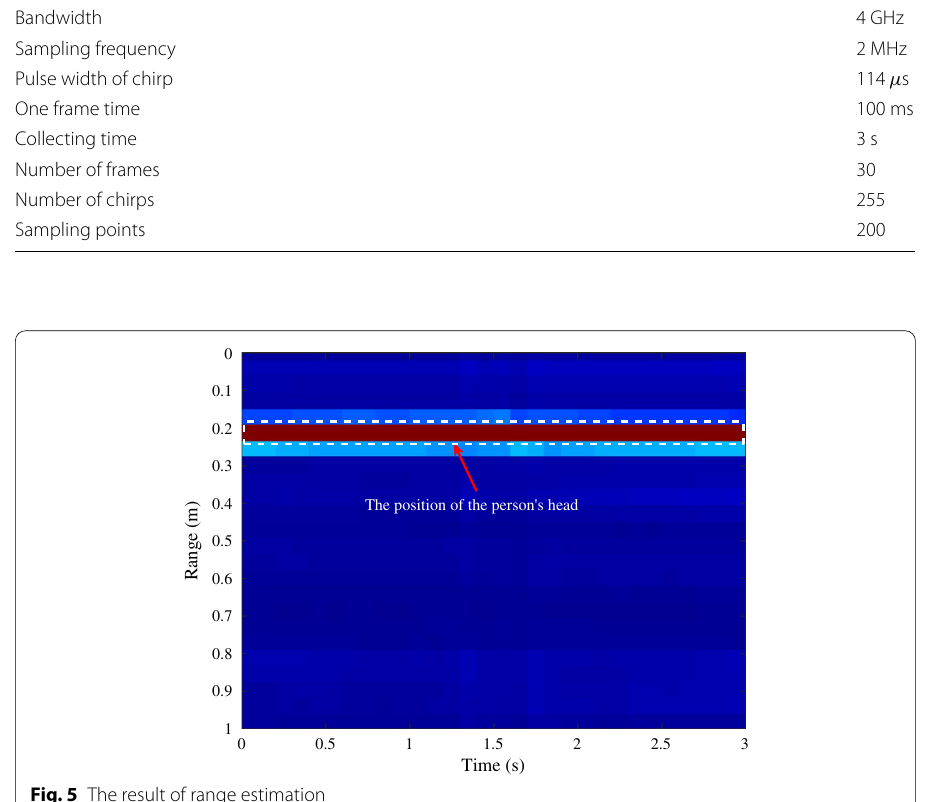
Fig. 5 The result of range